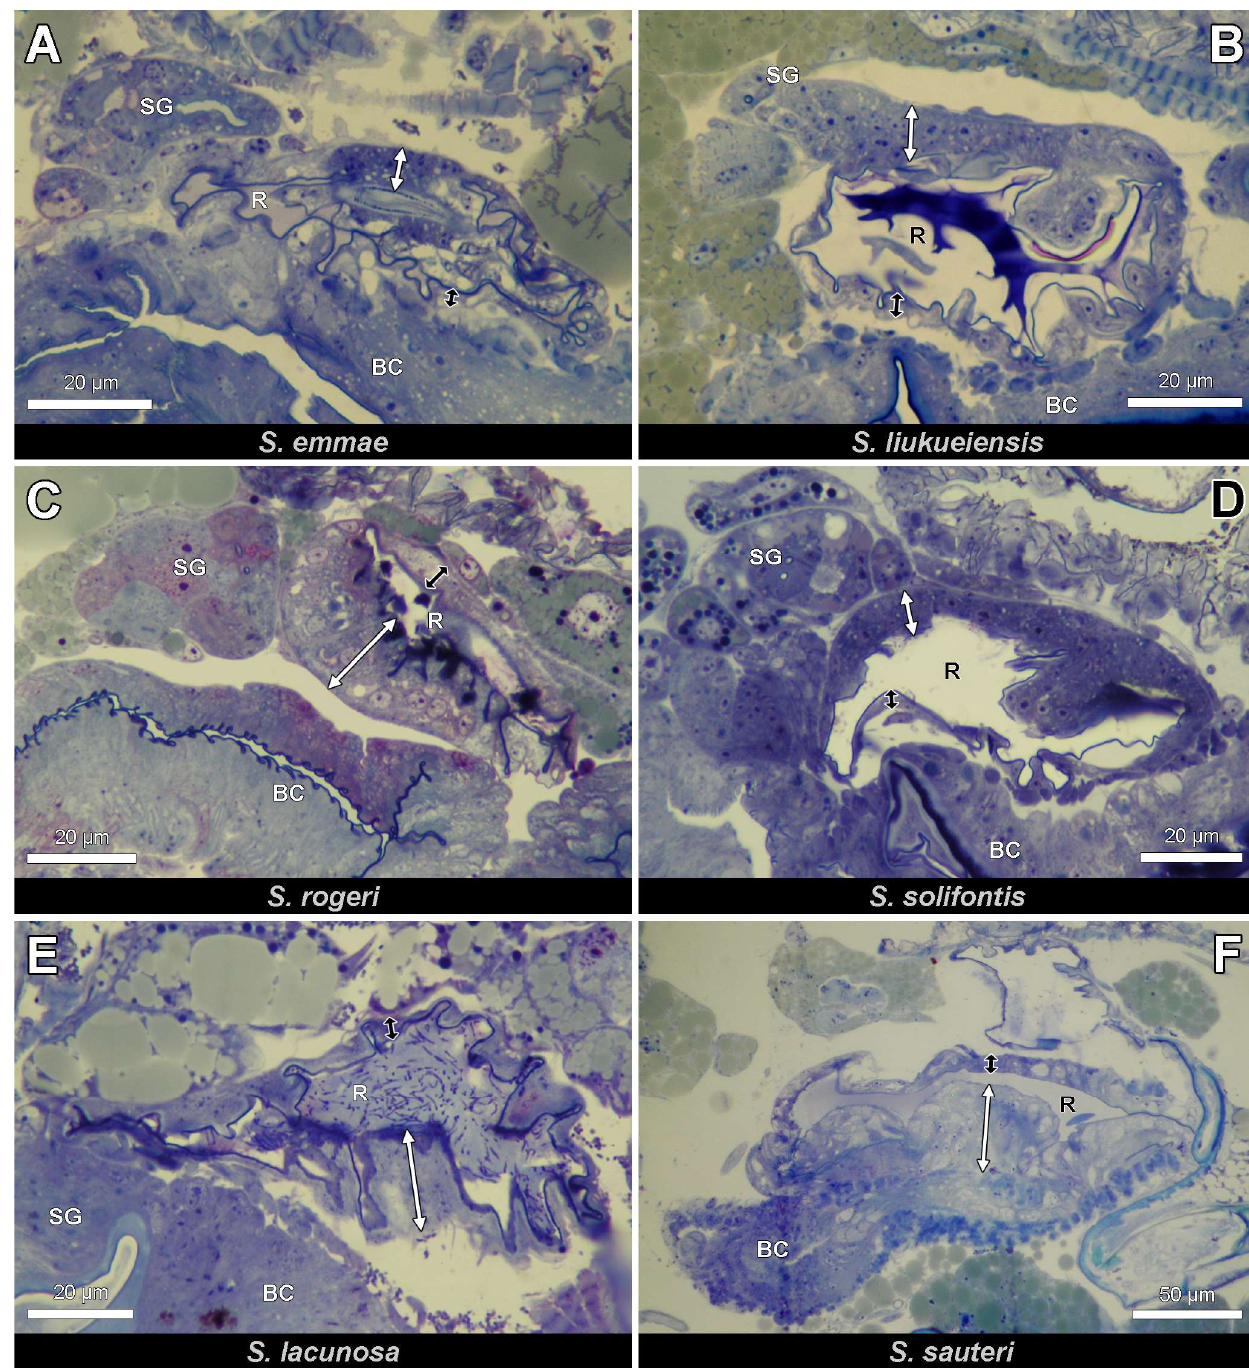
Figure 3. Close-up views (longitudinal sections, anterior to the left) of queen spermatheca in four parthenogenetic species ( A – D ) and two non-parthenogenetic species ( E , F ). Note similar morphology in all species with thick hilar (white double arrow) and thin distal (black double arrow) reservoir epithelium. BC: bursa copulatrix, R: reservoir, SG: spermatheca gland.